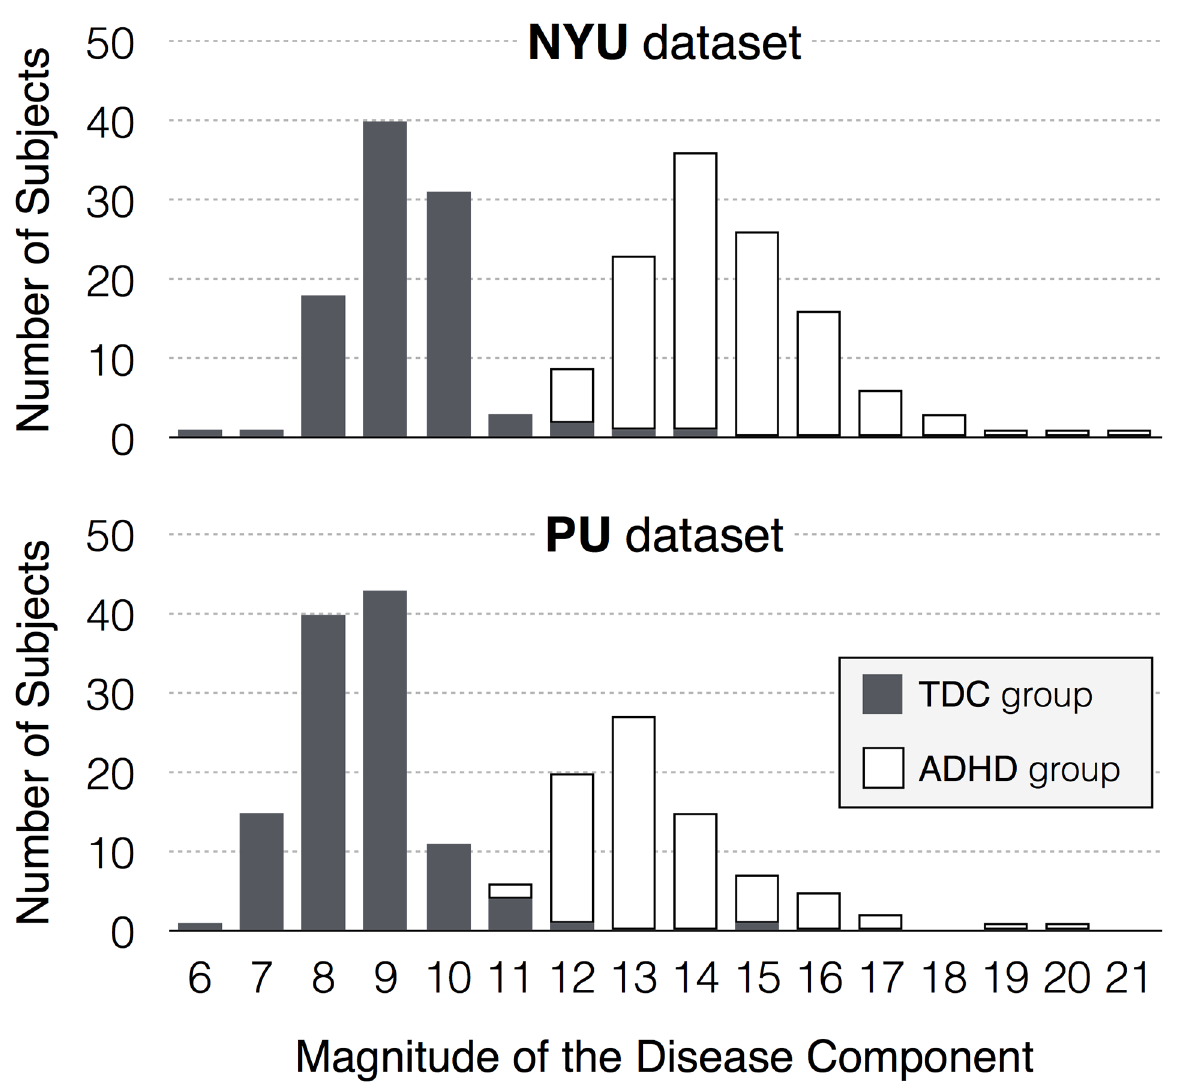
Fig 2. Distribution of the magnitude of the disease component (or the values of the filter function) for each group: the TDC group (gray bars) and the ADHD group (white bars).